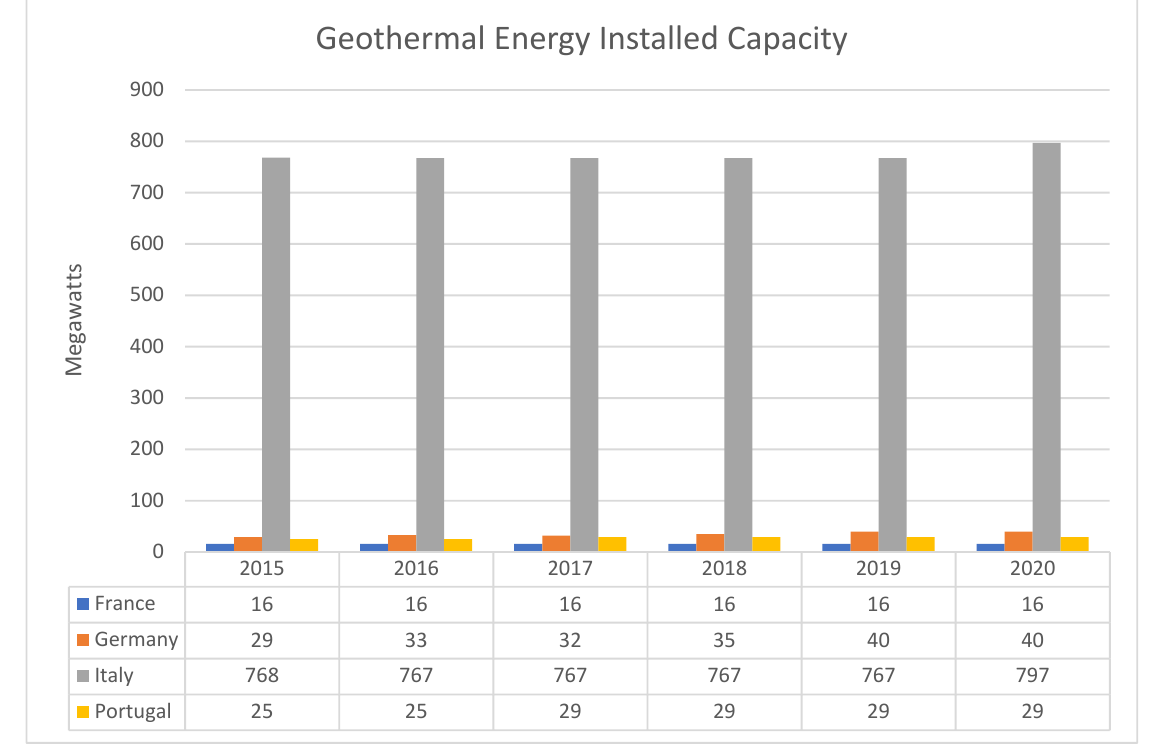
Figure 3. EU geothermal energy installed capacity 2015–2020 [51].